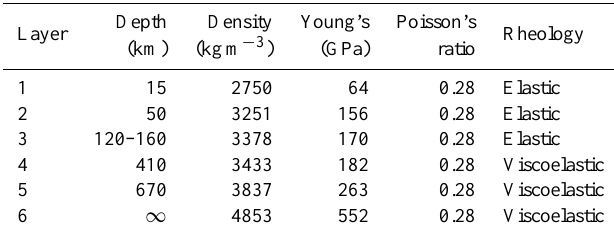
Table 1. Elastic material parameters and densities used in the earth models as derived from volume averages of PREM (Dziewonski and Anderson,